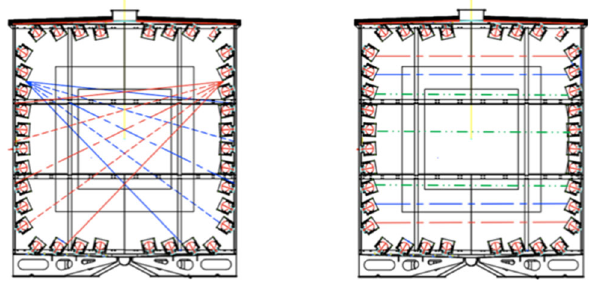
Fig. 26 Schematicviewoflightpathsinsidethedetectorfor2ofthe32 widebeamswithdiffuserdisks(left)andnarrowbeamswithoutdiffuser disks